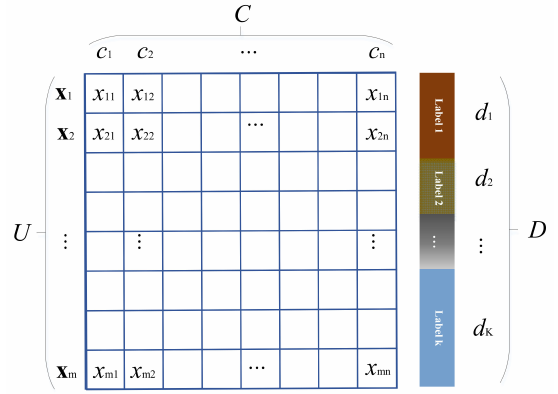
Figure 1. The illustration of a decision